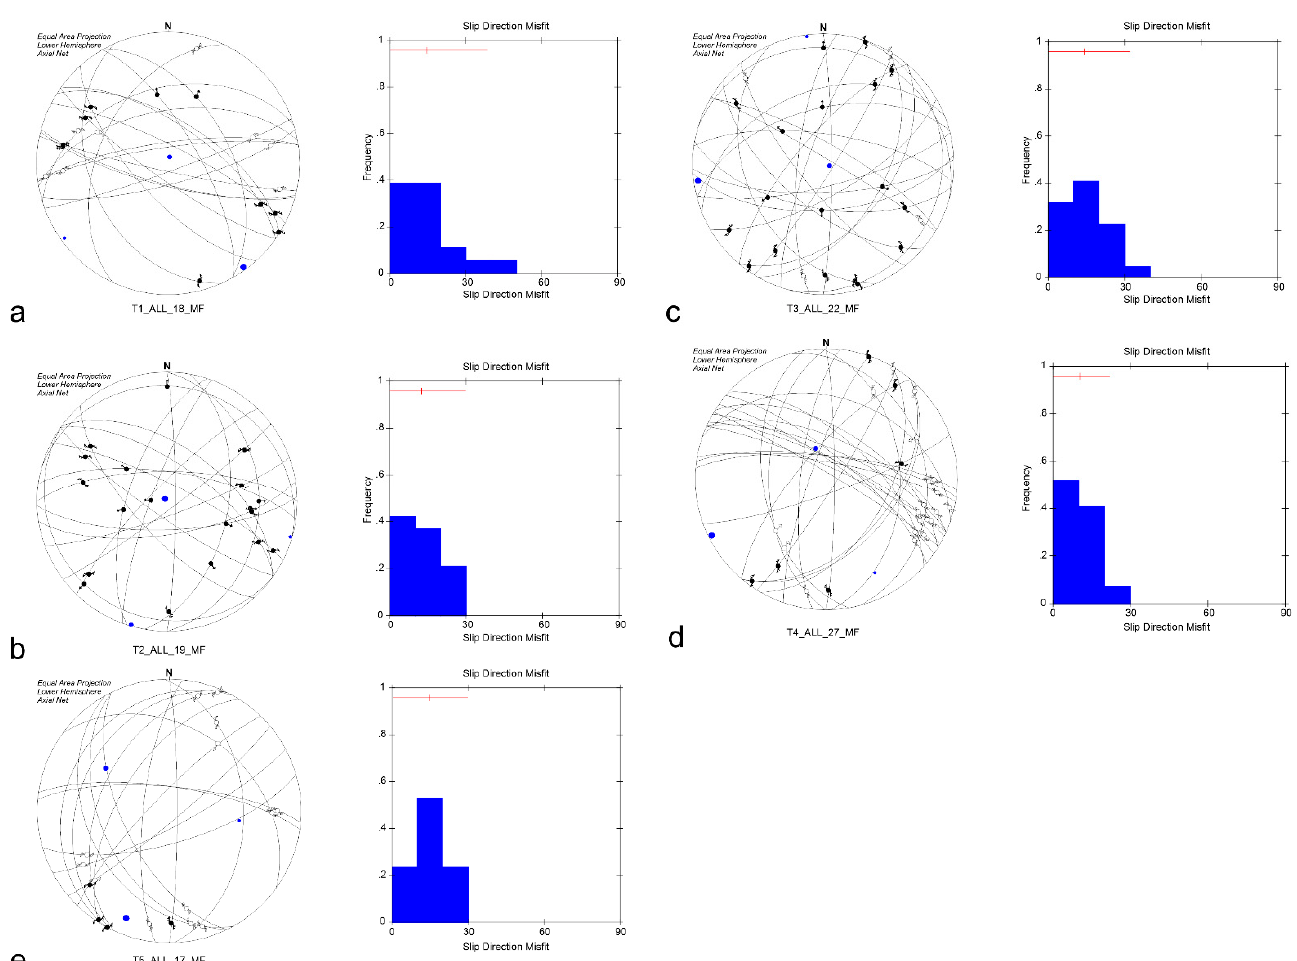
Figure 4. The application of the “Minimized Shear Stress Variation” best-fit stress inversion method with the aid of the software MyFault, which uses the algorithm of [81,82] on the T1 all through T5 all fault-slip data. ( a – e ) Stereographic projections and Misfit Angle (MA) histograms for the T1 MF through T5 MF resolved stress tensors. Explanation: The principal stress axes of the resolved stress tensor are shown with solid circles (maximum: biggest solid circle, intermediate: solid middle circle, and minimum: smallest solid circle). In the uppermost part of the MA histogram, the thin horizontal line centered on the mean shows the Mean Misfit Angle (MMA) and has a length equal to twice the 95% confidence value.